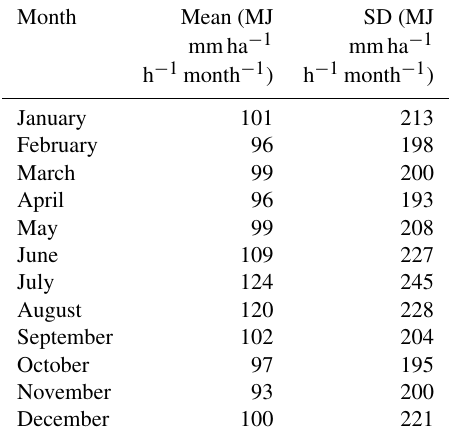
Table 2. Global monthly rainfall erosivity values using the CMORPH product. Mean and standard deviation are